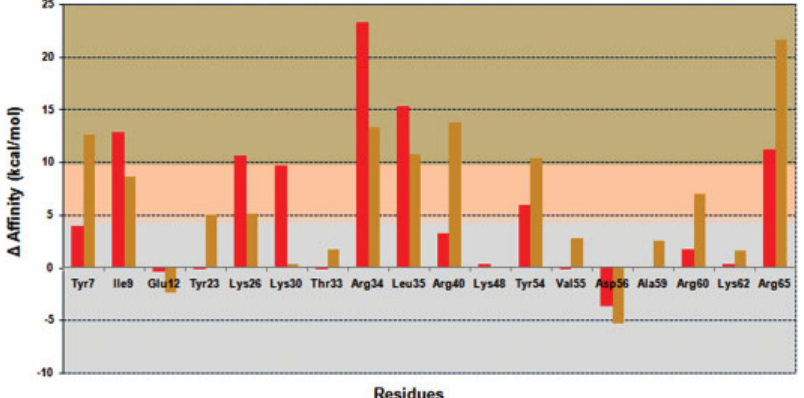
Fig.8 Alanine scan and comparison of Δ bindingaf fi nity. The plot shows the comparison of Δ bindingaf fi nity on mutation of residues involved in interactions of ringhalexin – TF and ringhalexin – TF-FVIIa. Color codes of bars: red, TF; gold, TF-FVIIa. Gradations: no signi fi cance < 5 kcal/mol; signi fi cant > 5 kcal/mol; strong > 10